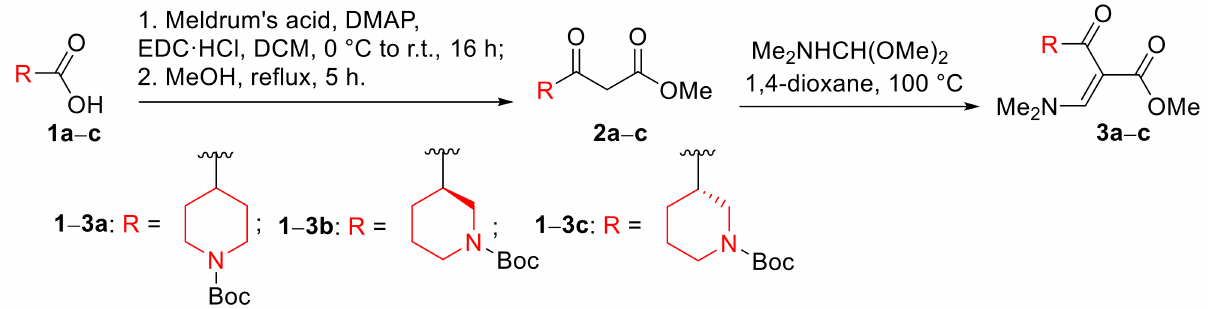
N -Boc protected piperidine acids 1a – c with 2,2-dimethyl-1,3-dioxane-4,6-dione (Meldrum’s acid) in the presence of 1-(3-dimethylaminopropyl)-3-ethylcarbodiimide hydrochloride (EDC · HCl) and 4-dimethylaminopyridine (DMAP), and further methanolysis of Meldrum’s acid adduct [50,51]. Compounds 2a – c were treated with N , N -dimethylformamide dimethyl